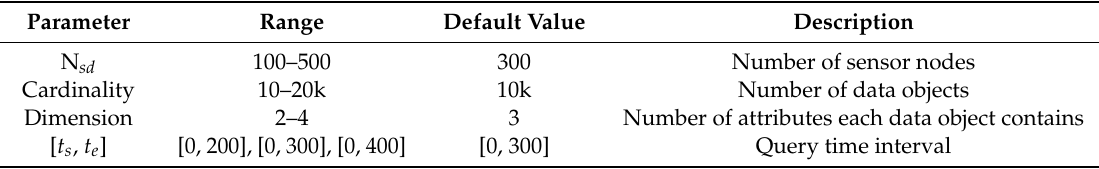
Table 3. Main simulation